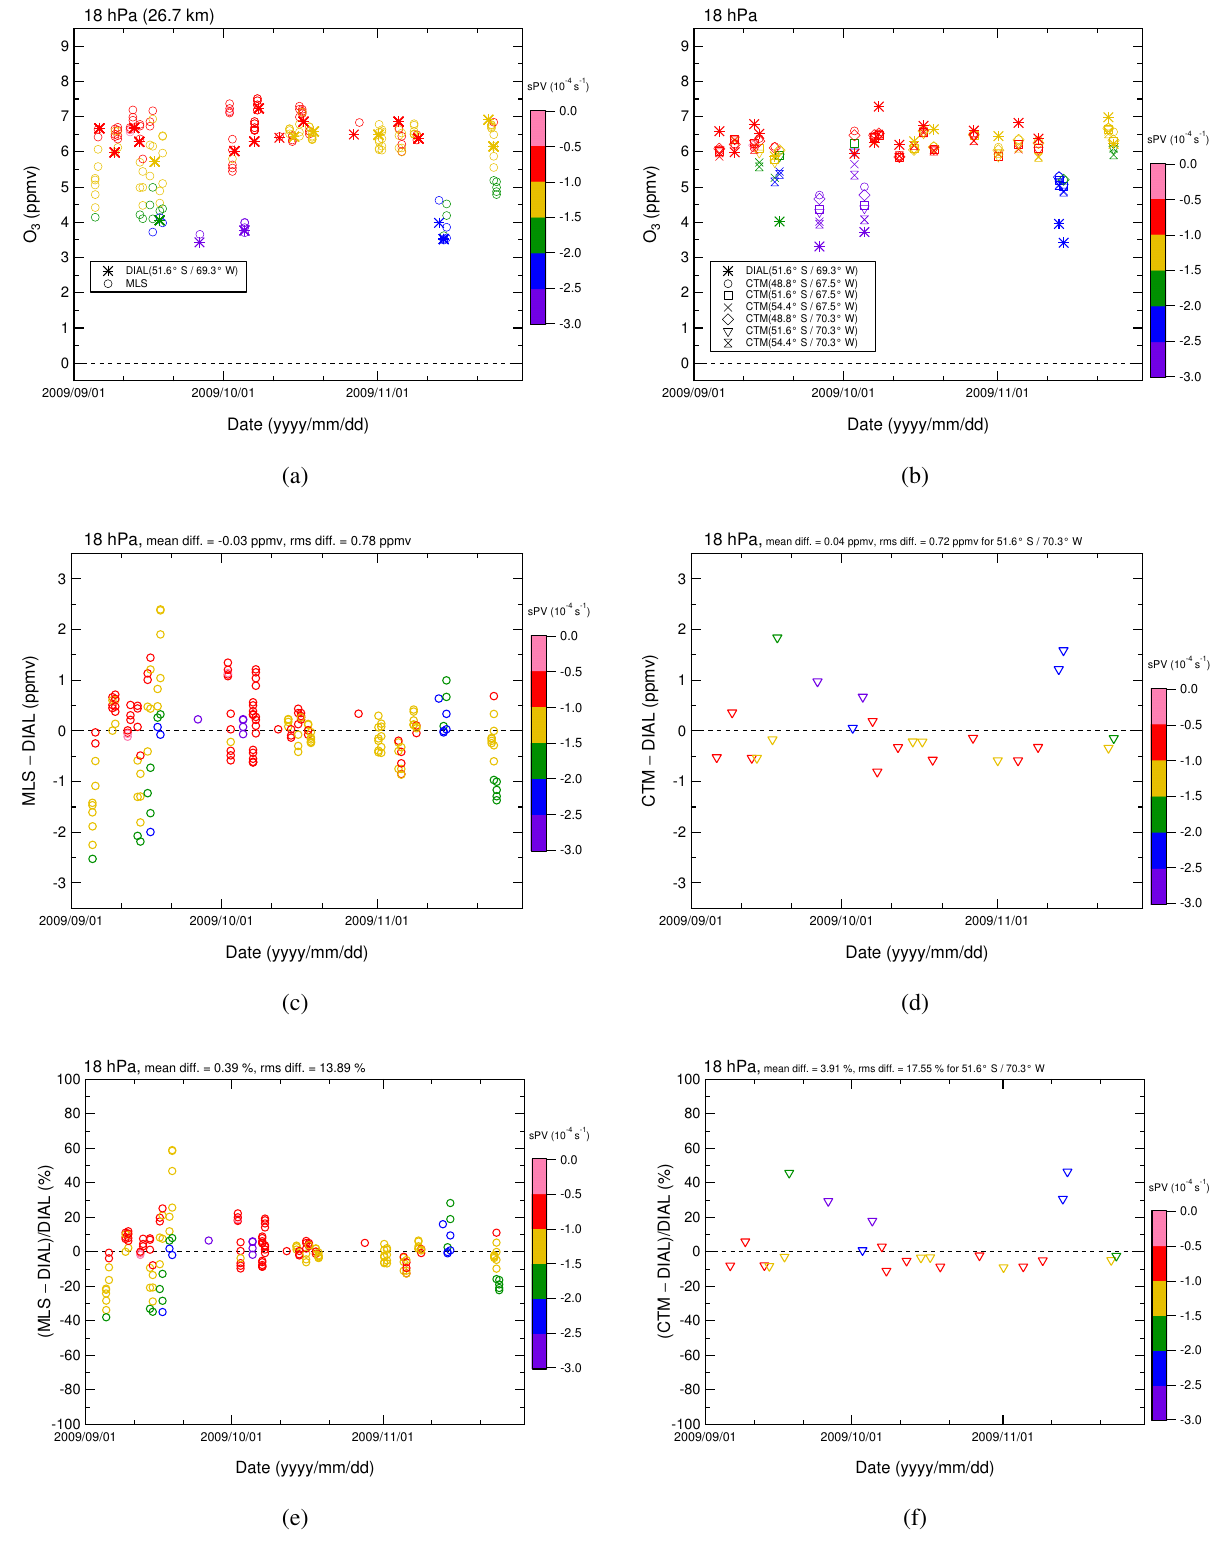
Figure 5. Time series of O 3 mixing ratios as measured by DIAL and MLS at 18hPa (a) and absolute and relative differences between the two (c, e) from September to November 2009, over the OAPA site. Panels (b) and (d, f) are the same as panels (a) and (c, e) , but for DIAL and MIROC-CTM. Data are color coded based on sPV values. For the absolute and relative differences, sPV values for MLS and MIROC-CTM are color coded. For MIROC-CTM, outputs from six grids are shown (see text for additional